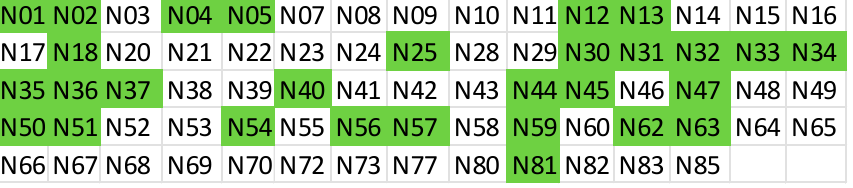
Table 4. Reduced diameter range ( ND = ND 0 = 10).